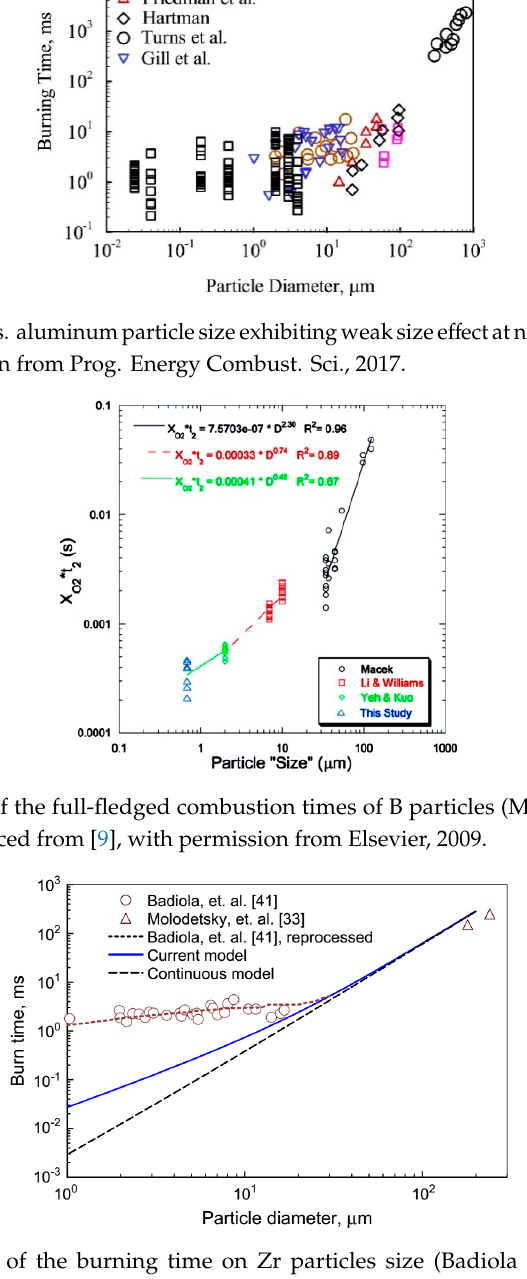
Figure 3. Dependency of the burning time on Zr particles size (Badiola [10], Molodetsky [11]). Reproduced from [12], with permission from Elsevier, 2013.